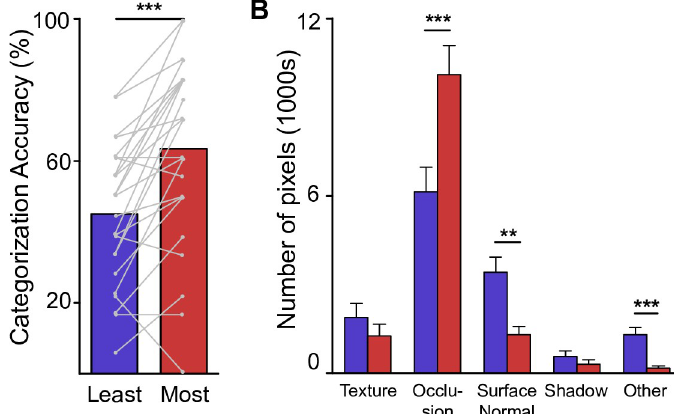
Fig 7. Results of Experiment 3. (A) Categorization accuracy for least and most consistent half drawings. (B) Number of pixels in particular types of contours in least and most consistent half drawings. �� p < 0.01, ��� p <